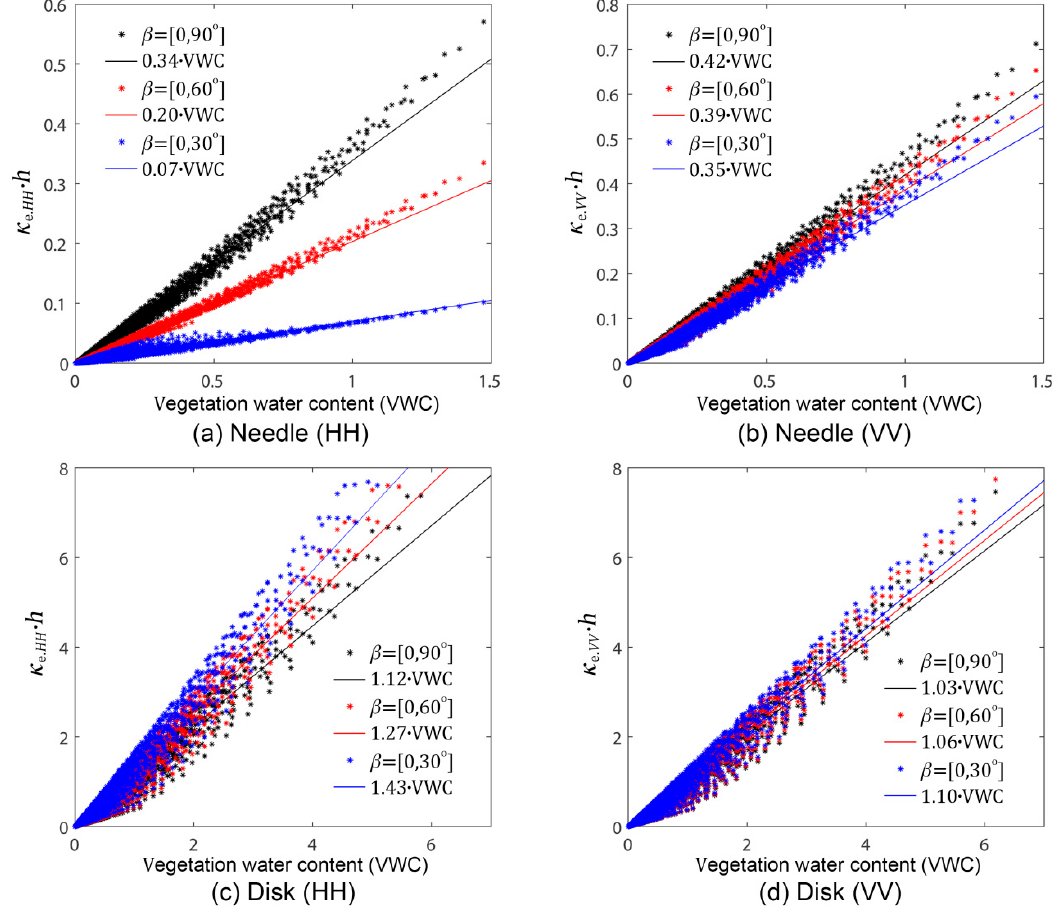
Figure 6. E ff ect of particle orientation distribution on the relationship between κ e , pq h and B 2, pq VWC (left: B 2, HH VWC and right: B 2, VV VWC ) in the case of ( a , b ) needle shaped and ( c , d ) disk shaped particles. Colored dots represent simulation results and solid lines are corresponding line fits to the simulated data.